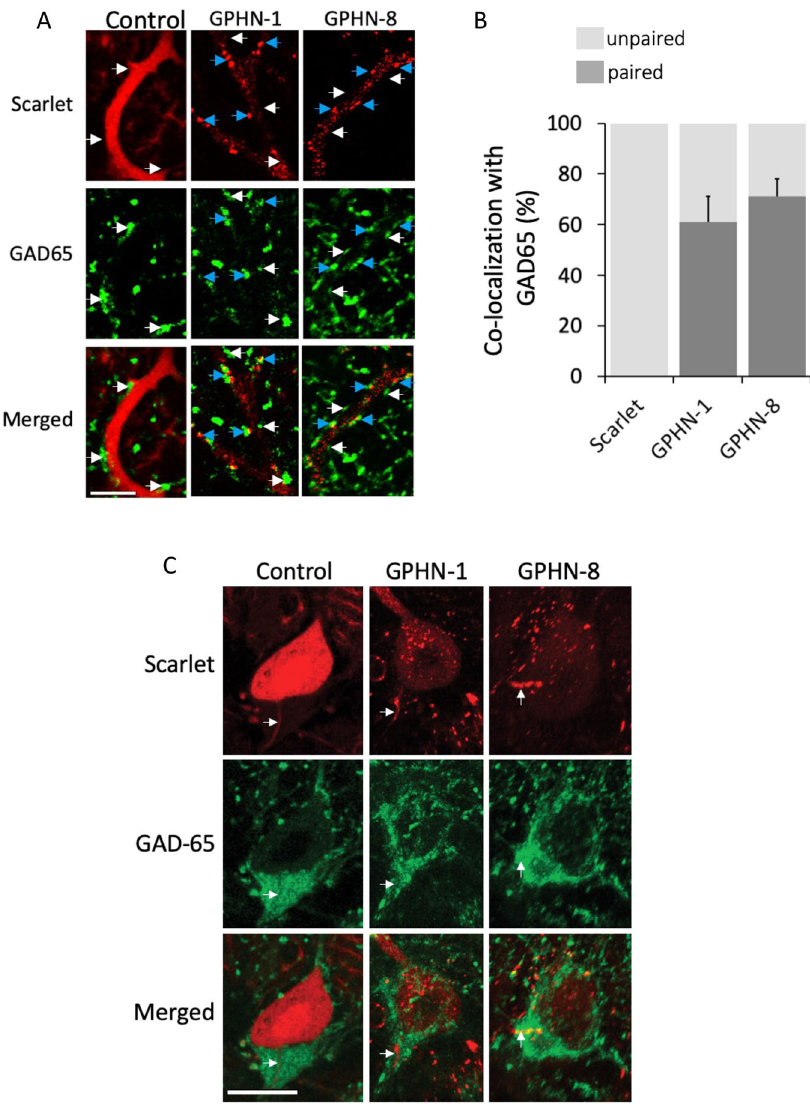
Fig. 6 Different recruitment ef fi ciency of GPHN isoforms to inhibitory synapses in mouse cerebellum. Comparative analysis of two GPHN isoforms having different clustering properties in mouse cerebellar Purkinje cells. An experimental procedure was performed like in Fig. 5A using three different viruses expressing respectively exogenous Scarlet and Scarlet-tagged GPHN-1 and − 8 (red). A Representative confocal images that display the exogenous proteins in PC dendrites of cerebellar slices. White arrows point to GAD65 synapses (green) connecting PC dendrites lacking exogenous proteins, while blue arrows point to GAD65 synapses containing postsynaptic exogenous proteins. B Quanti fi cation of inhibitory synapse co-localization of GAD65 and exogenous proteins ( n = 3 independent injected animals. Bar graphs show means ± SEM. C Different localization of Scarlet or Scarlet-GPHN isoforms (red) at the axon initial segment (AIS) of Purkinje cells in which GAD65 is immunostained (green). Note that only GPHN-1 and − 8 are detected at the AIS, while other isoforms such as GPHN-28 are not. Scale bars: 15 µ